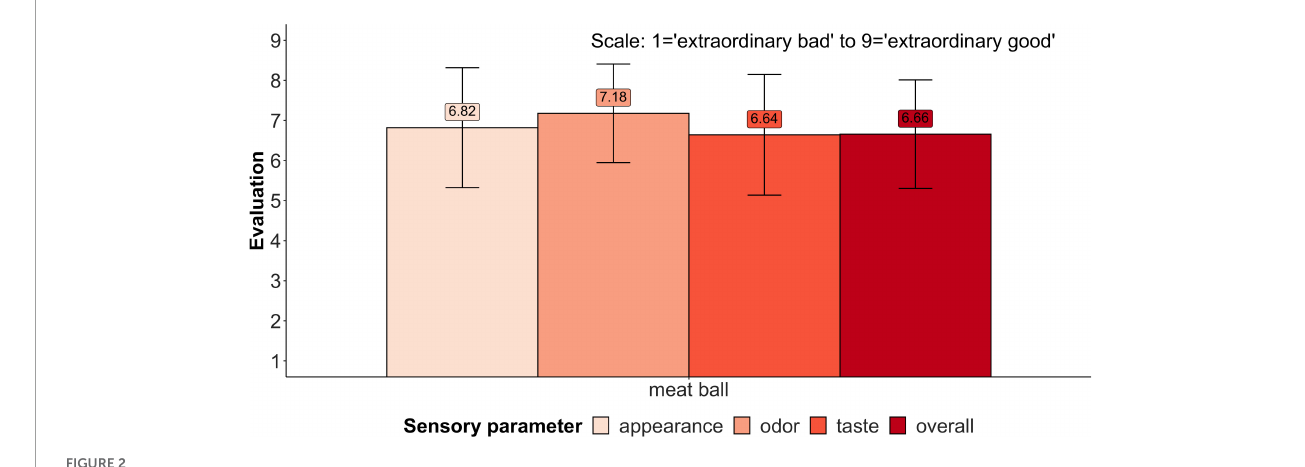
FIGURE2 Sensorial results - hedonic analysis.